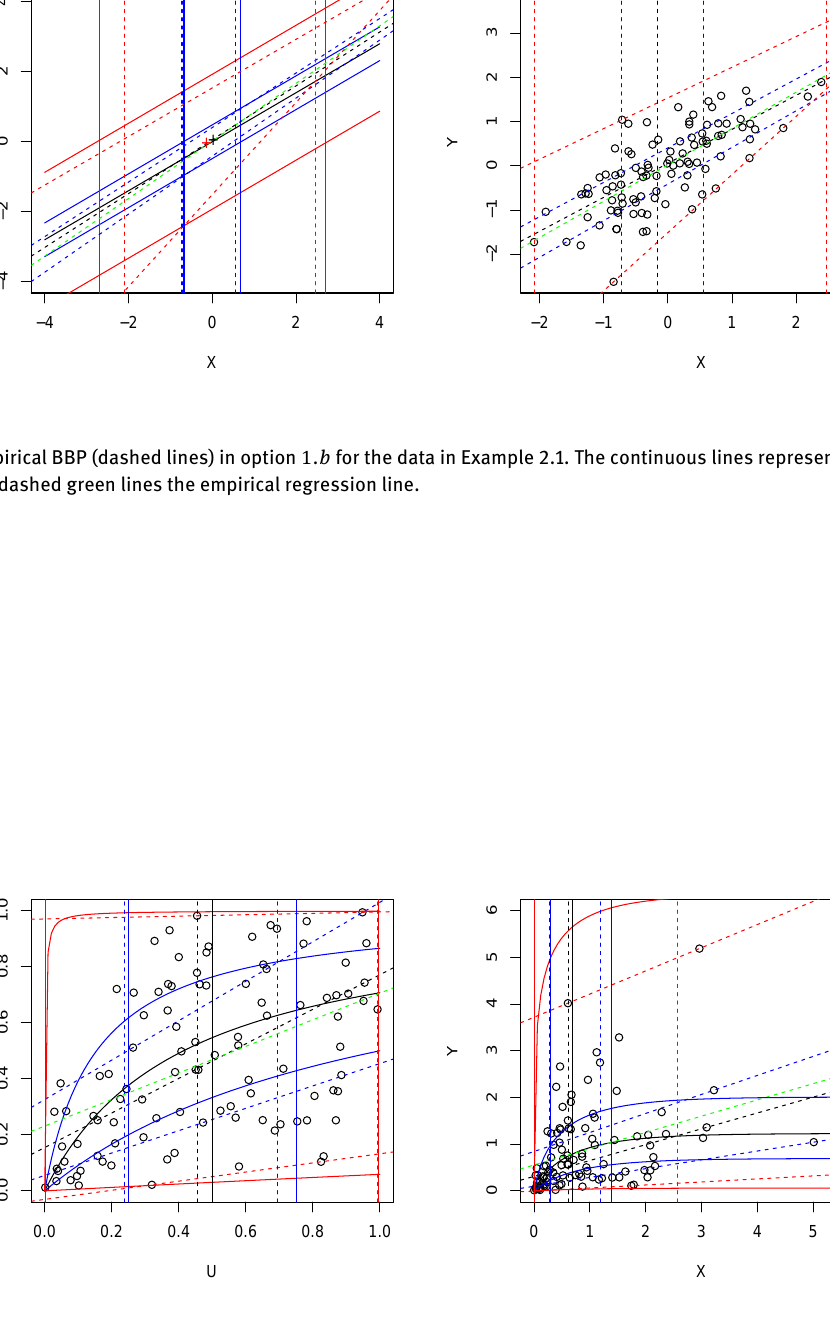
Figure 8: Empirical BBP (dashed lines) in option 1. b for the data in Example 2.2 with uniform (left) and standard exponential (right) marginals. The continuous lines represent the theoretical BBP and the dashed green lines the empirical regression